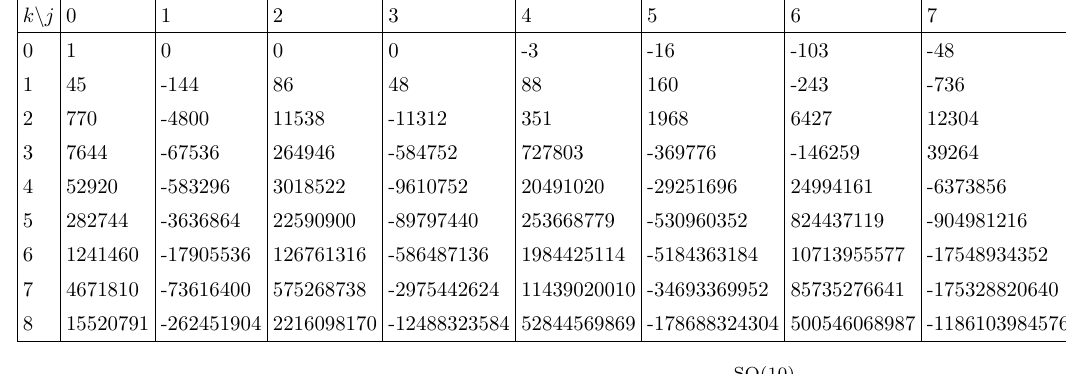
Table 59. Table of b jk coe(cid:14)cients for h SO(10)